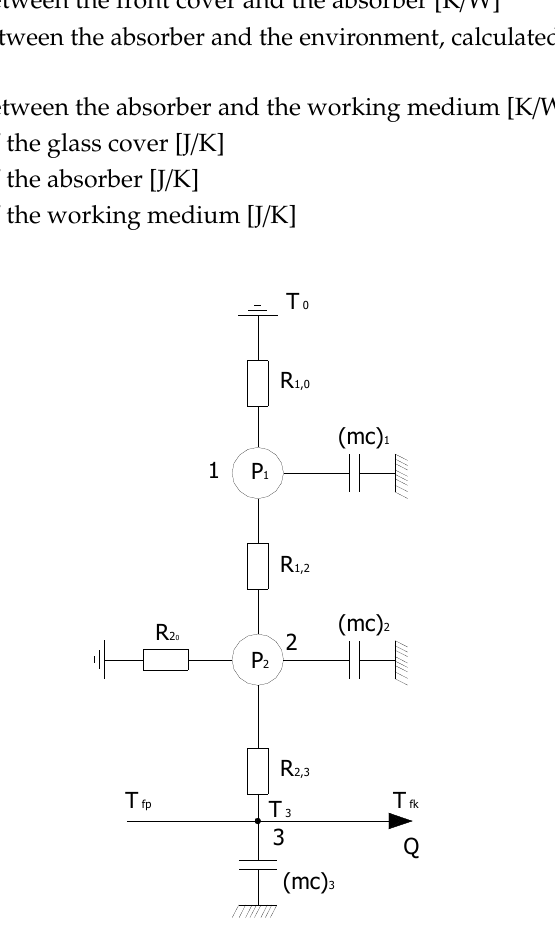
Figure 1. Thermal schema of the collector for a transient state.